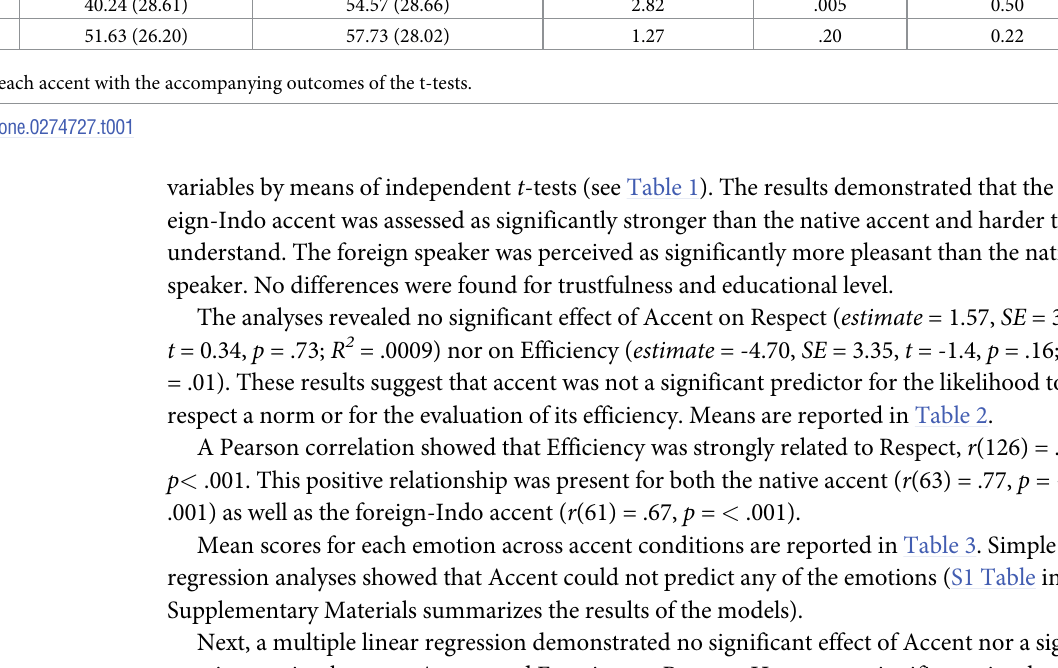
Means (SD) are presented for each accent with the accompanying outcomes of the t-tests.